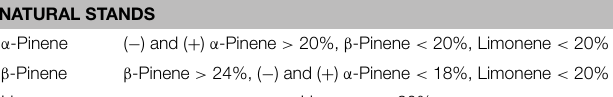
FIGURE 2 | Non-metric multidimensional scaling (NMDS) plots of monoterpene proportions of jack pine ( Pinus banksiana ) in (A) natural stands and (B) provenance stands. Points are divided by chemotypes defined by a hierarchical cluster analyses performed on samples from each respective stand type. Vectors represent individual monoterpene proportions. Each point represents an individual